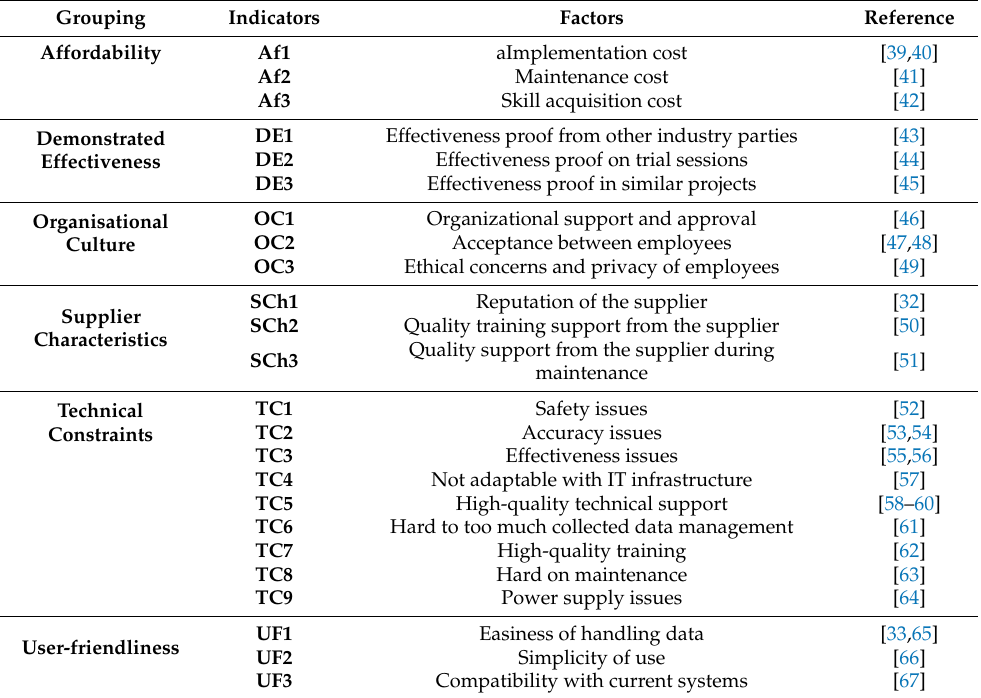
Figure 2. Method for literature review. Table 1. Influence factors on sensing technologies adoption in